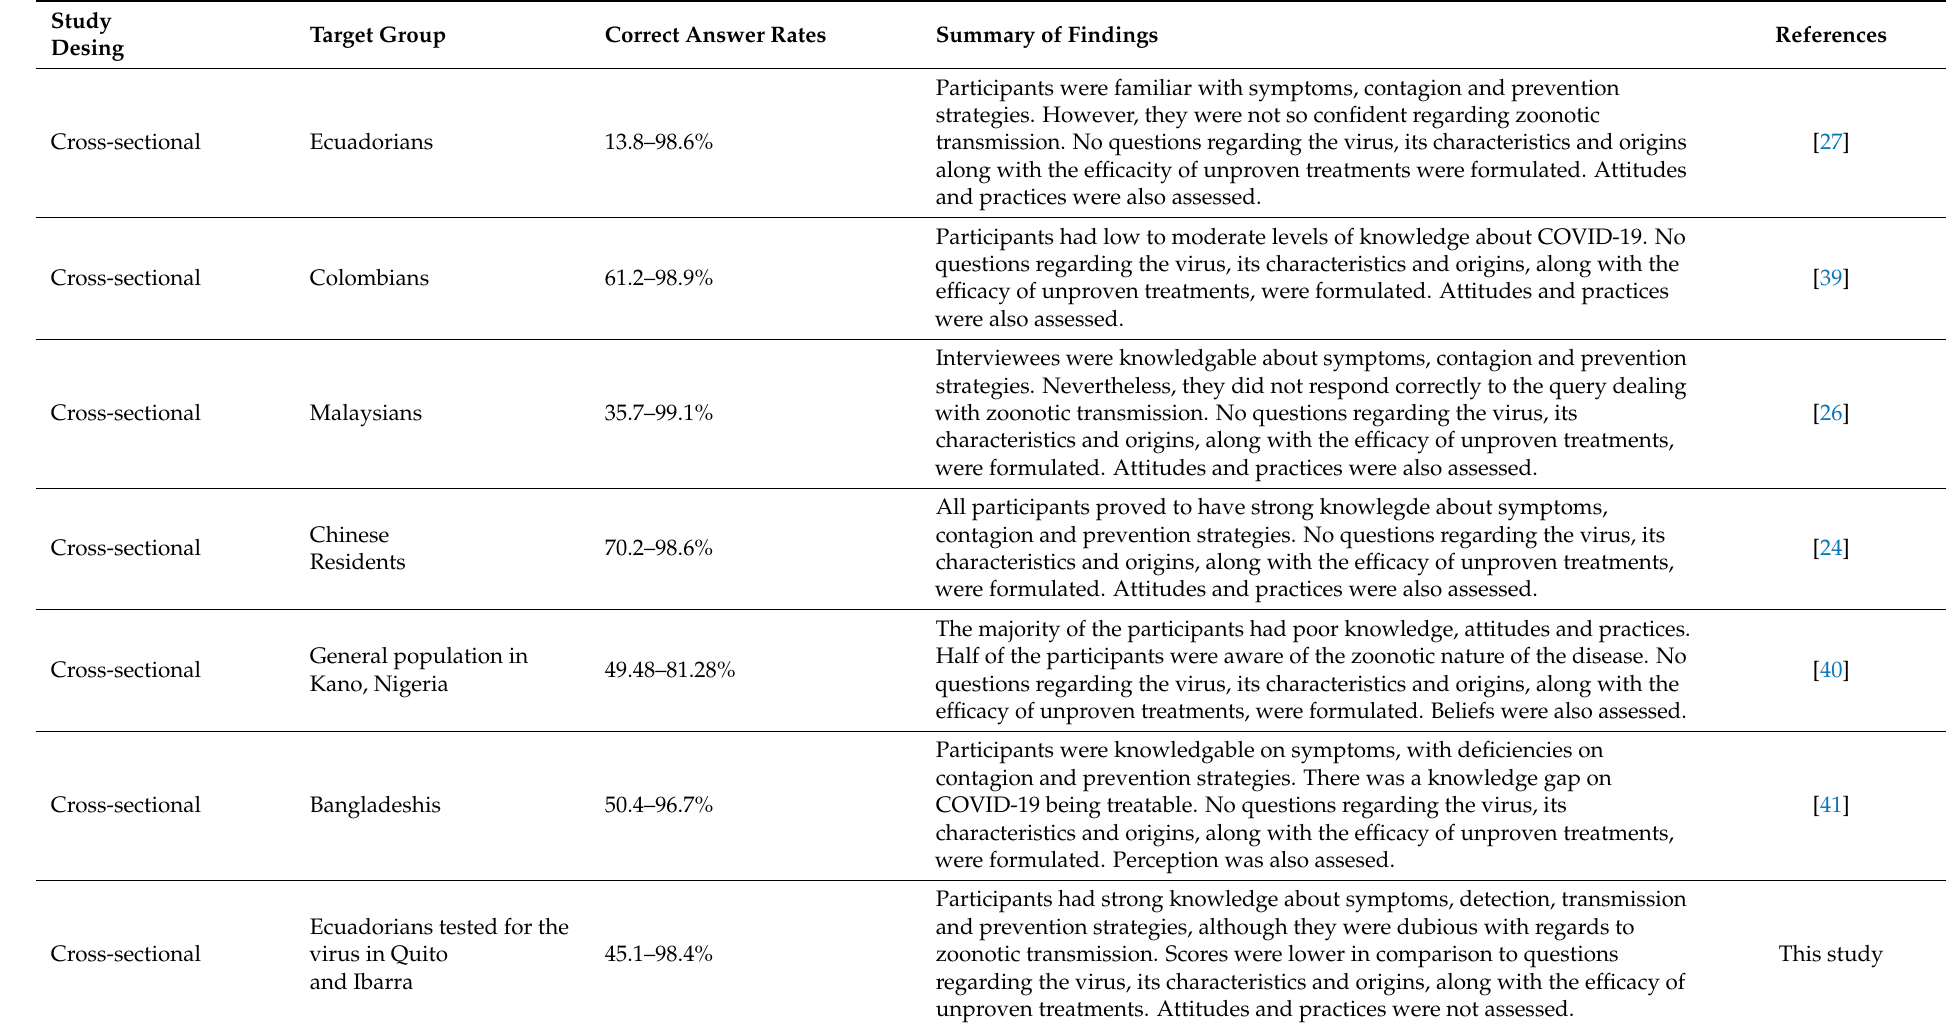
Table 4. Summary of studies assessing knowledge of the COVID-19